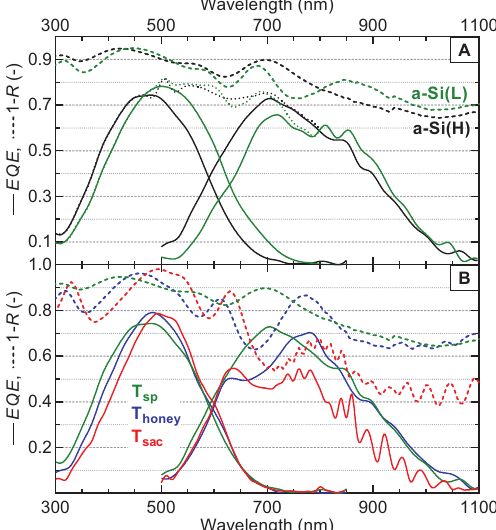
Fig. 11. EQE and 1-R spectra as a function of wavelength. A shows the spectra of tandem devices with a-Si(H) and a-Si(L) absorber on T sp (6.5 mins) textured substrate, with dotted line indicating EQE -sum. B shows the spectra of tandem devices with a-Si(H) absorbers on T sac (6.5 mins), T sac (12mins) and T sac ( d asi =1500 nm) textured substrates.